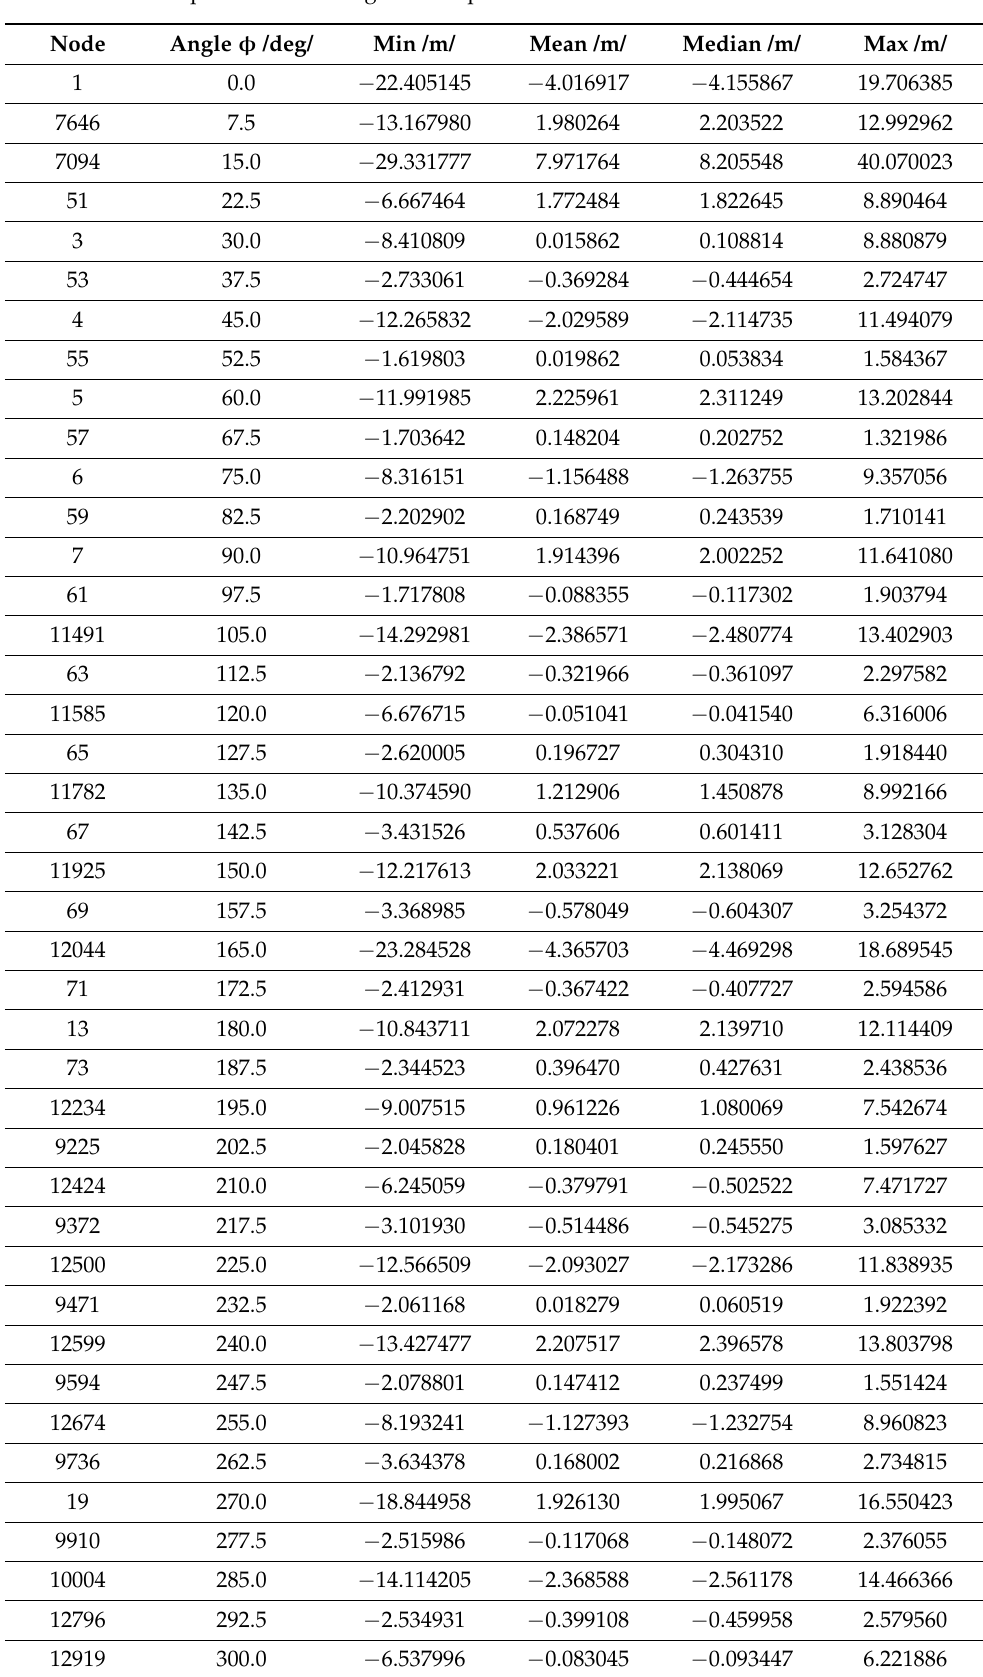
Table 2. Statistical parameters of tangential